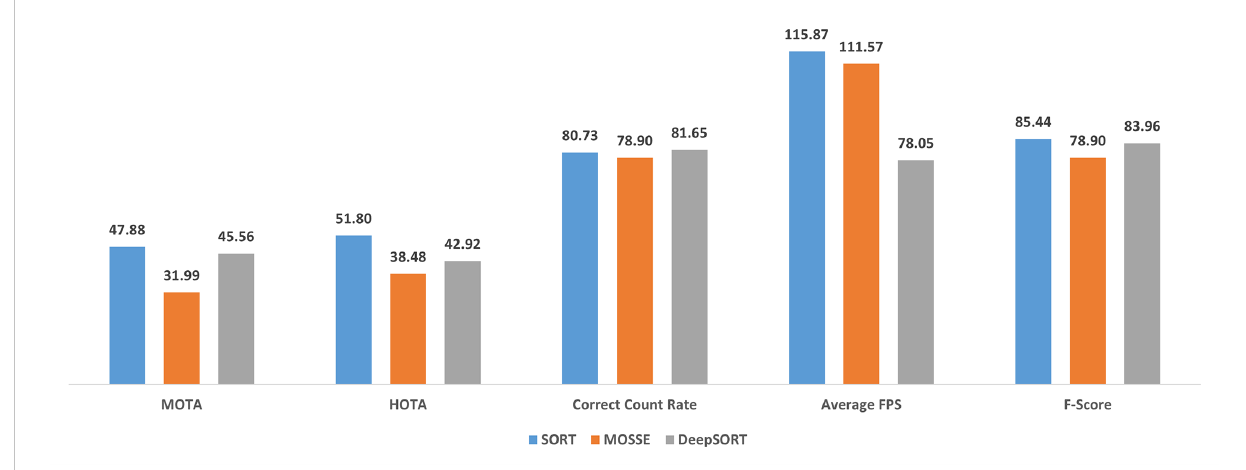
FIGURE 5 Some performance metrics obtained by three different object tracking